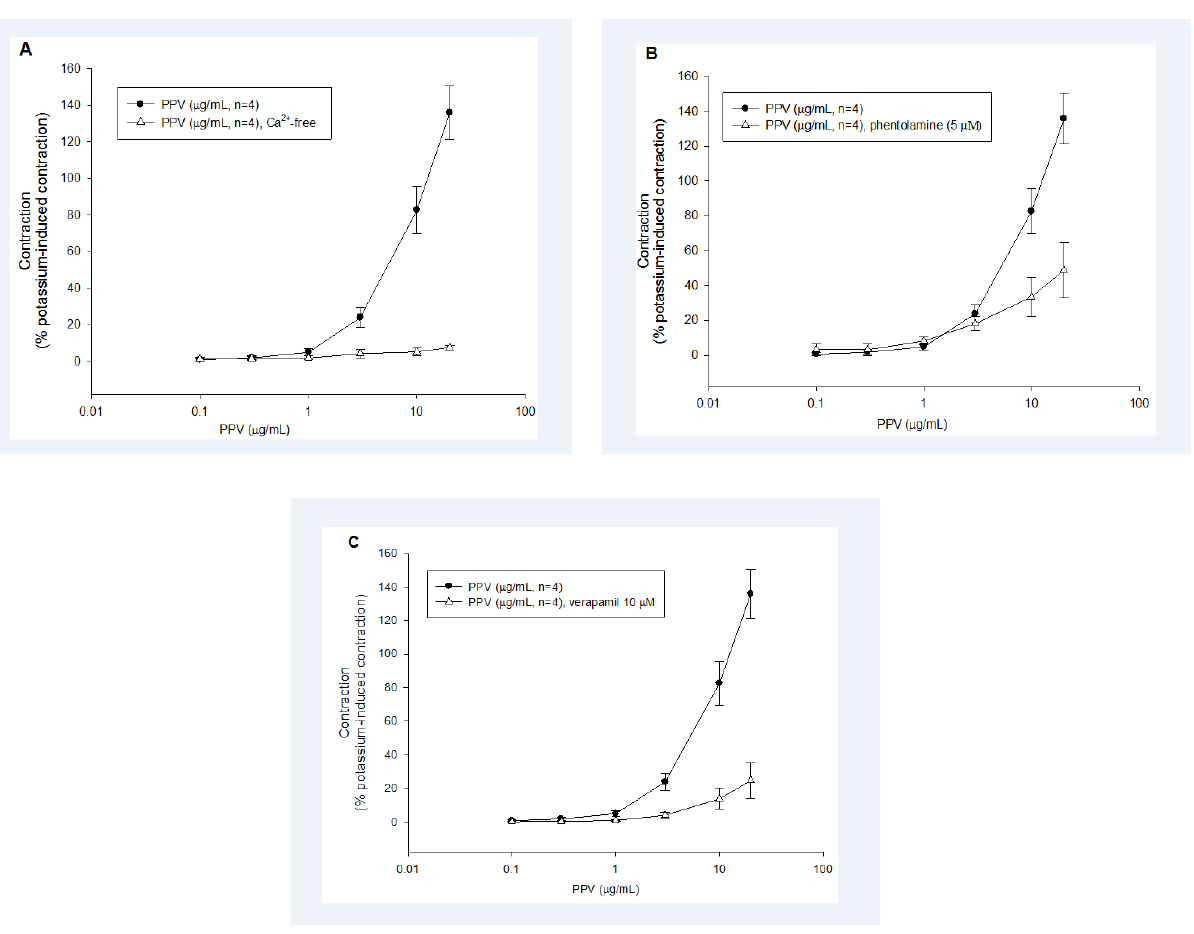
Figure 5. ( A ) Concentration response curve of Polybia paulista venom (PPV) in isolated aortic rings ( ● , n = 4; 0.1-20 µg/mL), and venom with Ca 2+ -free medium (Δ, n = 4; 1µM). ( B ) Concentration-response curve of PPV in isolated aortic rings ( ● , n = 4; 0.1-20 µg/mL) and venom with phentolamine (Δ, n = 4; 5 µM). ( C ) Concentration-response curve of PPV on potassium-induced (K + , 60 mM) contraction of isolated aortic rings ( ● , n = 4; 0.1-20 µg/mL) and venom with verapamil (Δ, n = 4; 10 µM). Data are expressed as means ± SEM, one-way ANOVA, post-test Holm-Sidak, *p < 0.001, compared with corresponding baseline